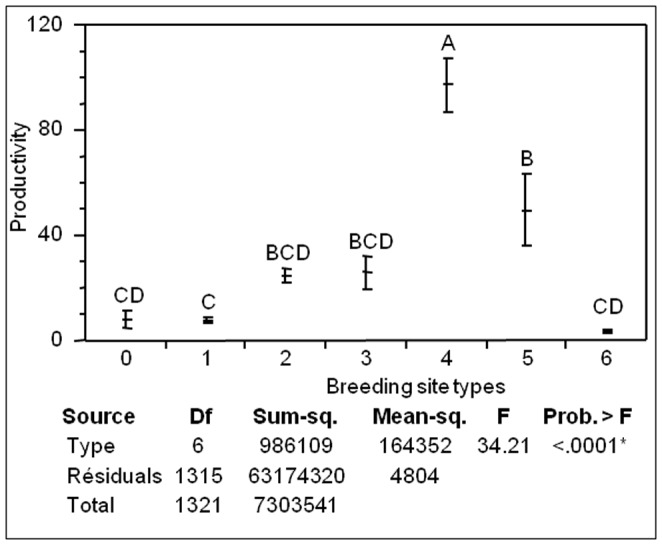
Productivity of breeding site of Aedes albopictus (N = 1949 observations).Natural breeding sites (0), Flower plates (1), Small recipients (2), Big recipients (3), Tires (4), Basin and reservoir (5) and vegetal breeding sites (6). Different letters mean that the mean values of productivity (average of larvae and pupae in a breeding site) are statistically different (Tukey's t test; P<0.05).